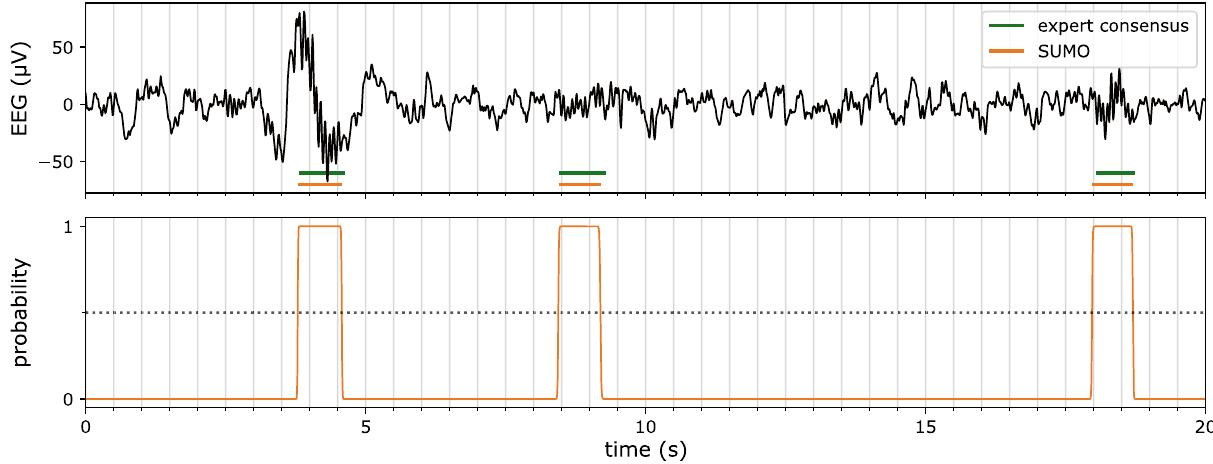
Figure 2. Comparison of SUMO predictions with expert consensus on an exemplary EEG segment. Top panel: A 20 s long segment of N2-sleep EEG from the test set shows three spindles marked by the expert consensus (green marks). Our trained SUMO model detects all three spindles with about 90% overlap (orange marks). Bottom panel: The predictions are generated by thresholding SUMO’s output probabilities (orange line) with a threshold of 0.5 (black line).